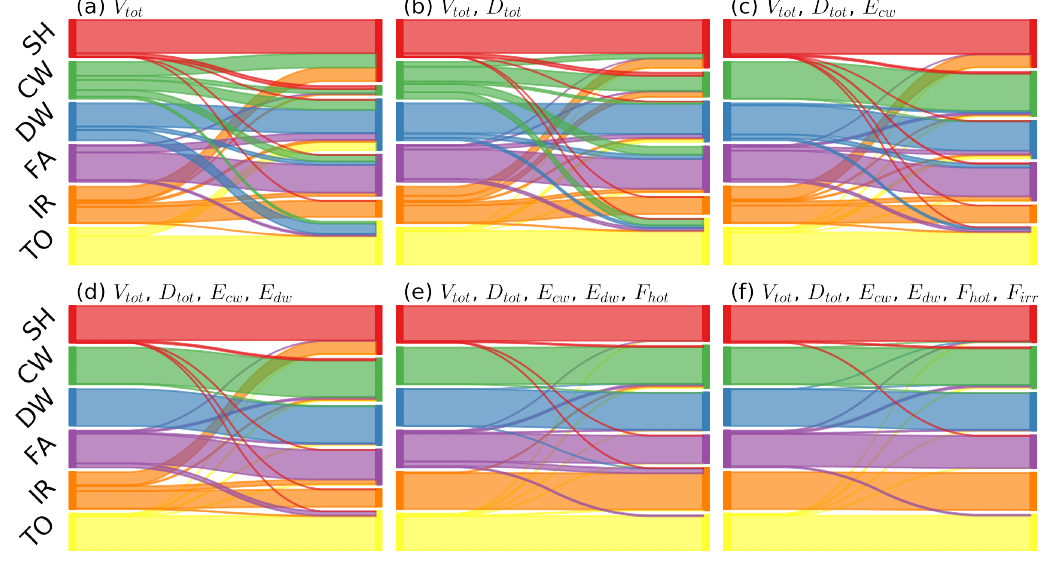
Figure 4. Sankey diagram representation of classifier performance on testing data with one to six input features: ( a , b ) a significant fraction of actual events incorrectly flow to predicted